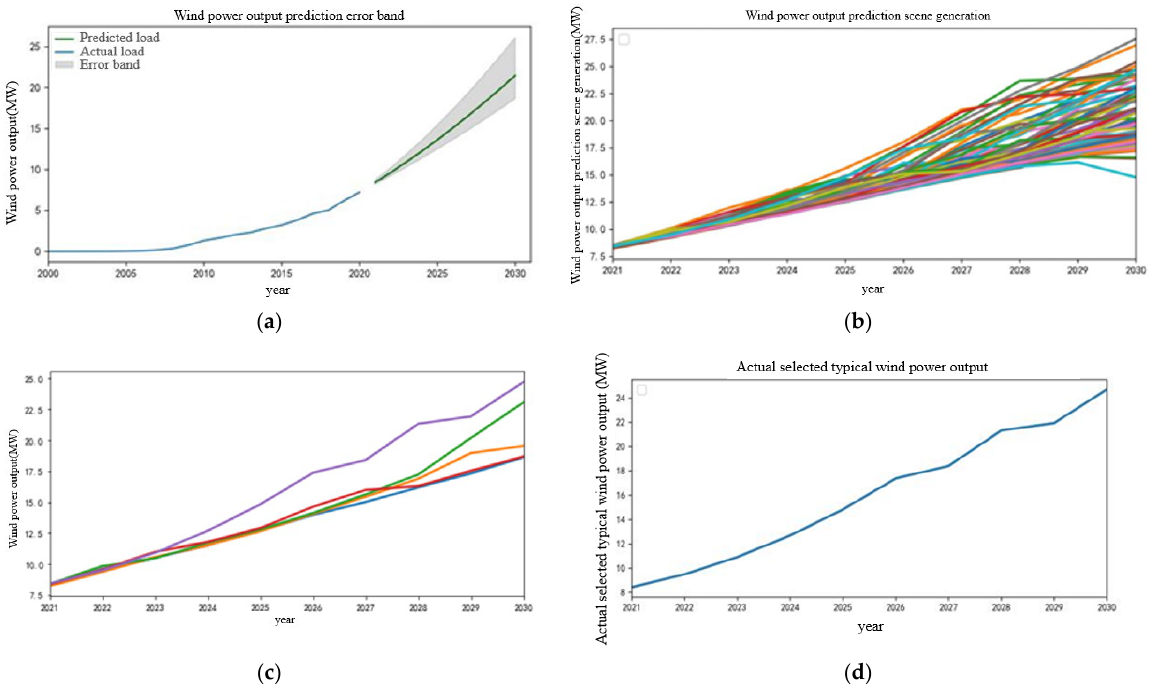
Figure 8. Wind power output forecast chart. ( a ) Wind power output prediction error band. ( b ) Wind power output prediction scenario generation. ( c ) Wind power output scenarios in the next 10 years after reduction. ( d ) Actual selected wind power output scenarios.